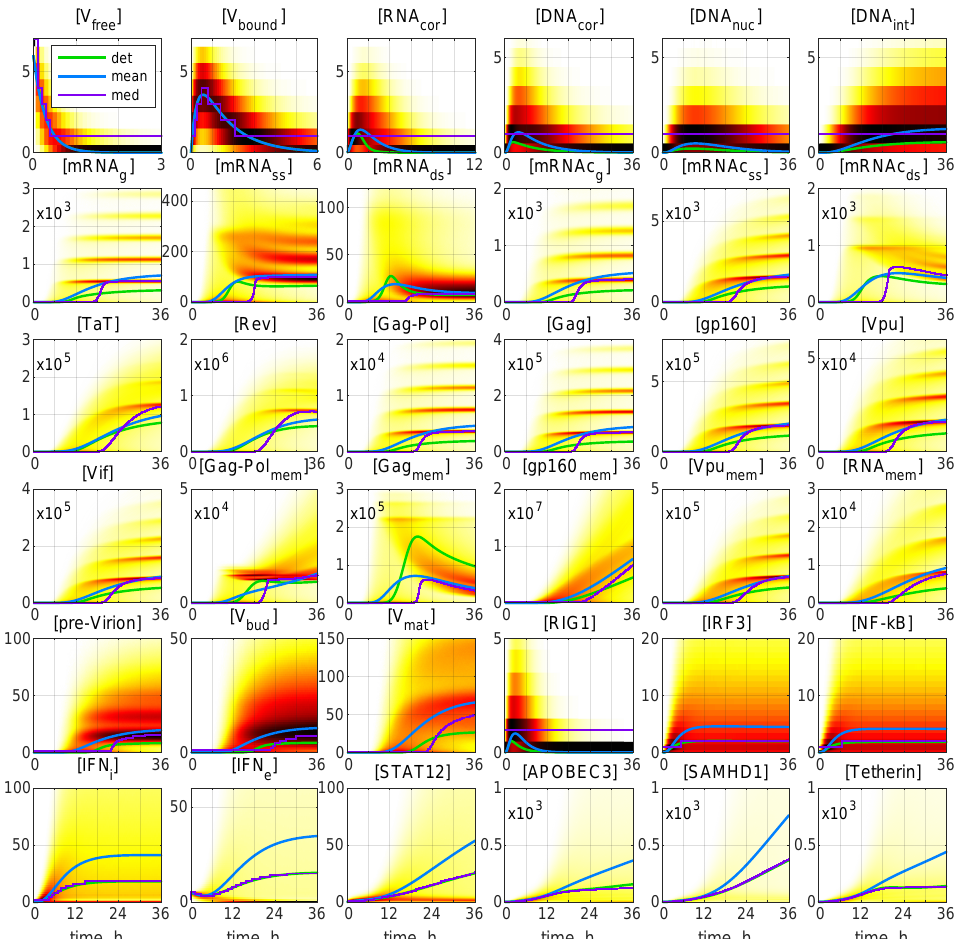
Figure 6. Probability density function (PDF) of stochastic realisations. Sliding histograms for 36 components for MOI = 6 and [ IFN e ]( 0 ) = 5. Furthermore, the deterministic solutions (det), mean values (mean), and medians (med) are plotted (colours for the lines are explained in the leg- end). A darker colour corresponds to a higher value of the histograms. Multi-hump patterns in the trajectory ensembles are present in the histograms for all the model components.